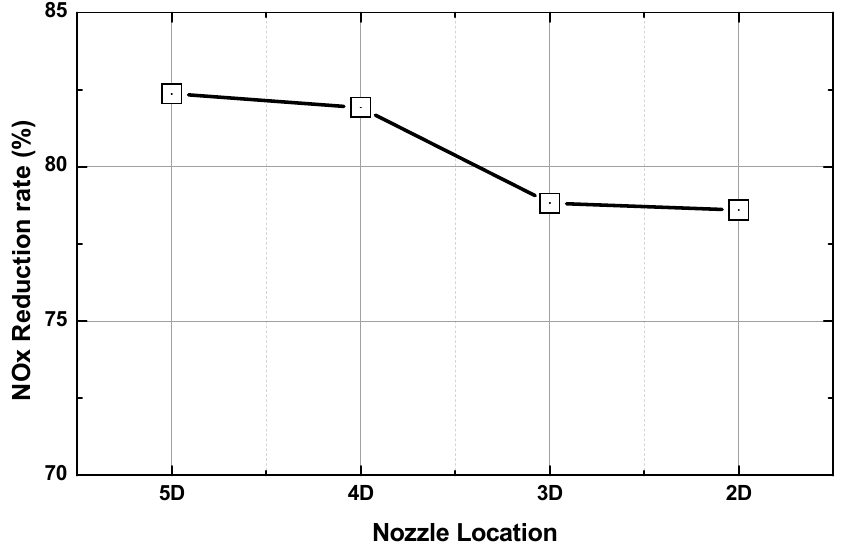
Figure 8. Characteristics of NOx reduction rate in relation to distance from the urea nozzle.